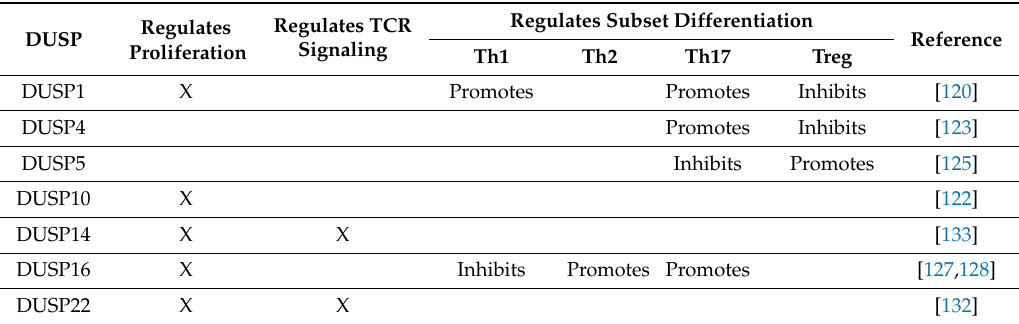
Table 1. Roles of DUSPs in T